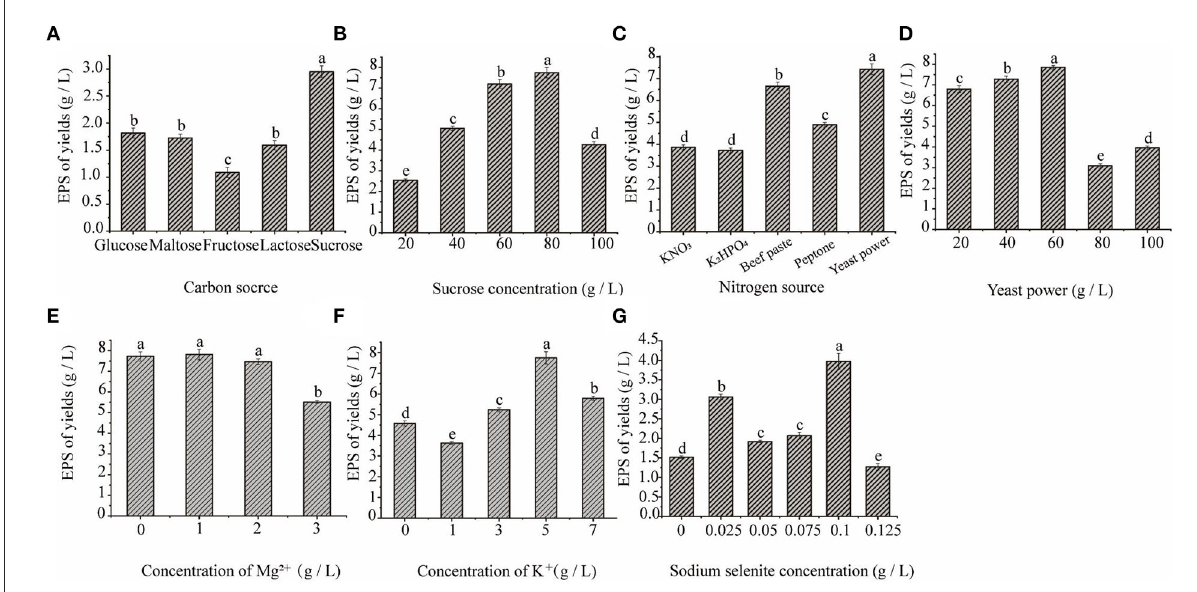
FIGURE3 The effect of carbon source (A) , sucrose concentration (B) , nitrogen source (C) , yeast powder concentration (D) , magnesium ion concentration (E) , potassium ion concentration (F) , and sodium selenite concentration (G) on C. cicadae polysaccharide